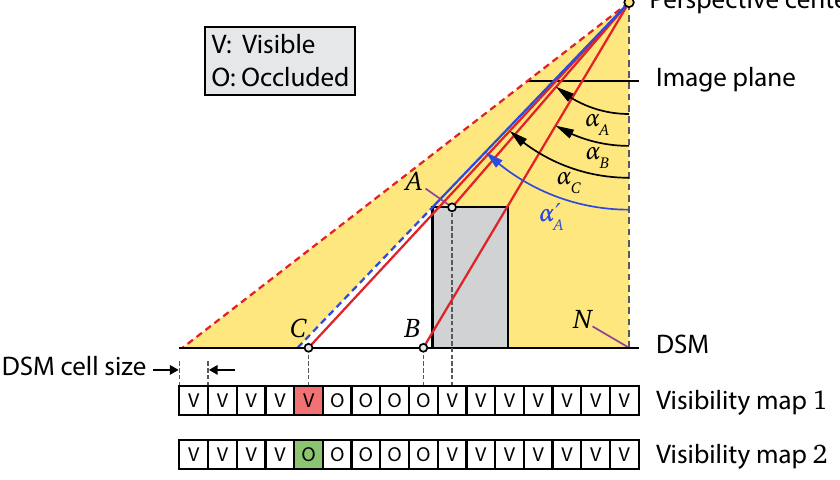
Figure 7. Conceptual details of occlusion extension within the angle-based